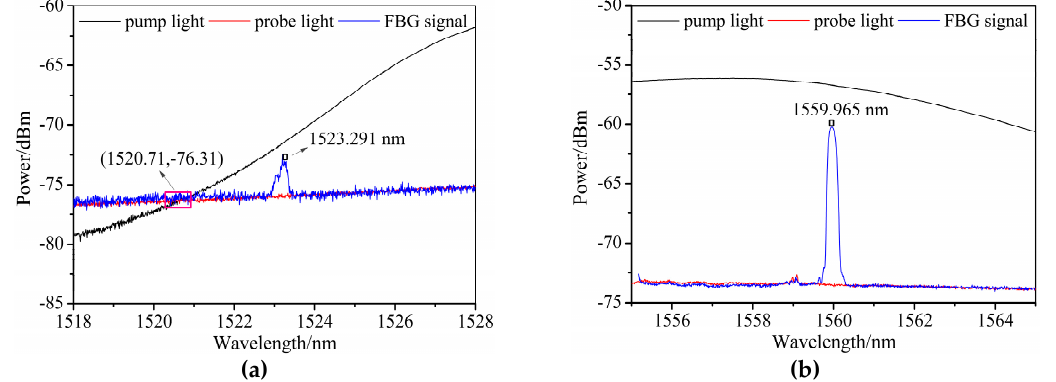
Figure 6. The signal-to-noise ratio (SNR) of XFG sensors with different center wavelengths: ( a ) from 1518 nm to 1528 nm; ( b ) from 1555 nm to 1565 nm.